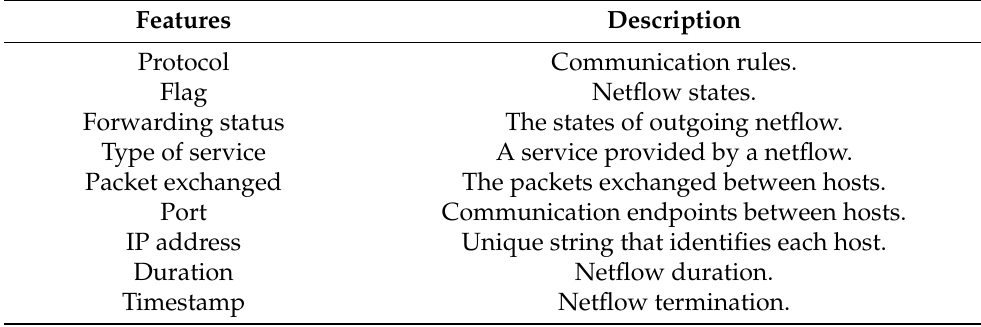
Table 2. Relevant features of the UGR’16